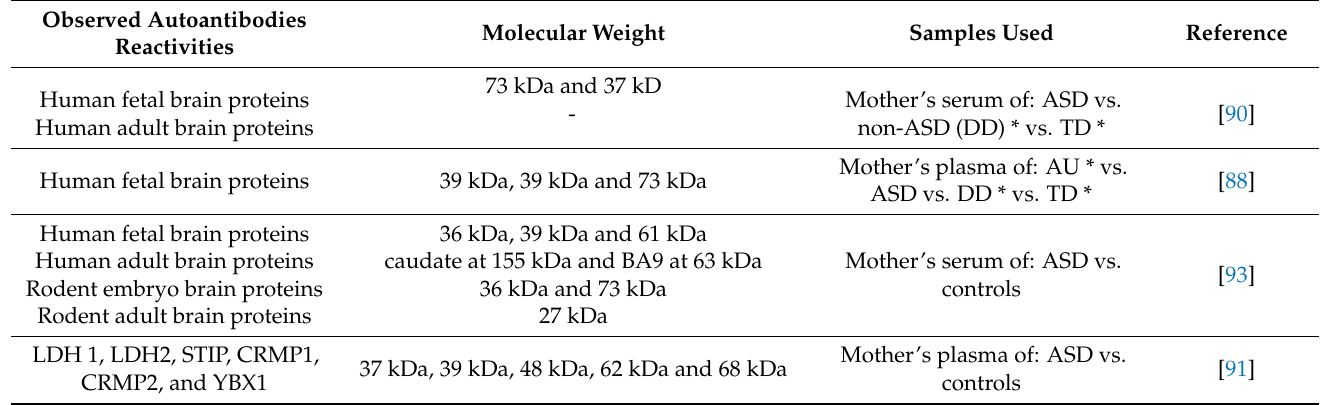
Table 3. Autoantibodies studies on